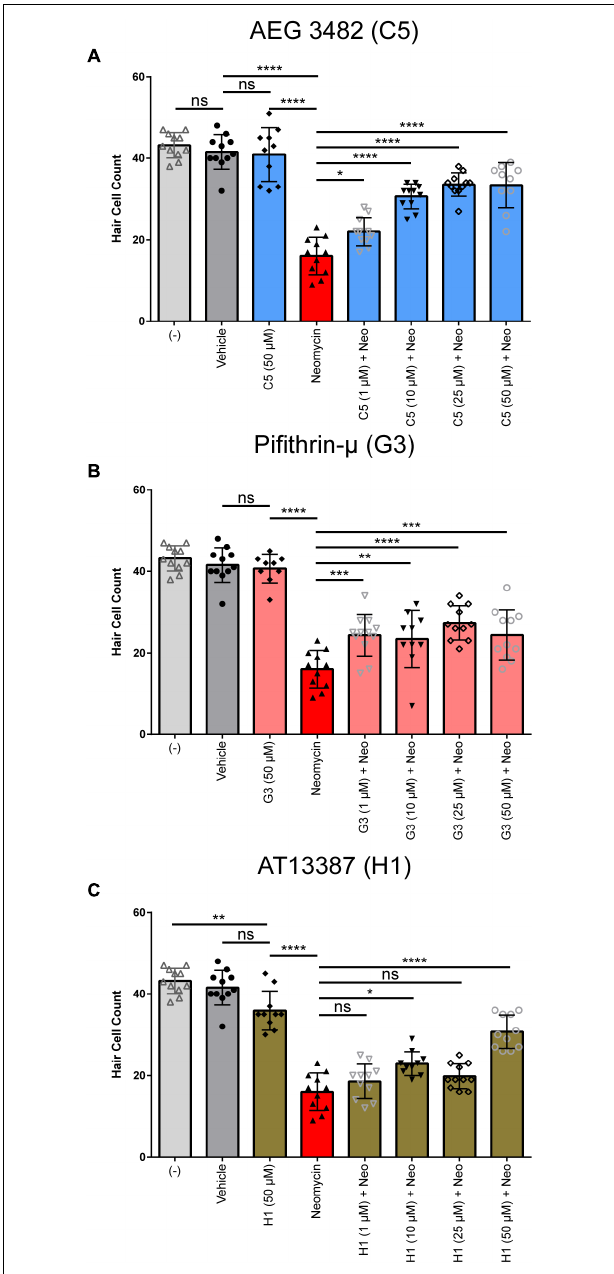
FIGURE 5 | All perturbagen hits show protection against neomycin-induced hair cell death at multiple doses. (A) Dose–response relationship for C5 (AEG 3482, blue). Hair cells were counted from anti-parvalbumin-labeled neuromasts. (B) Dose–response relationship for G3 (Pifithrin- µ , pink), (C) Dose–response relationship for H1 (AT-13387, brown). Negative control, vehicle, and neomycin plus vehicle groups are identical in all three experiments, as all doses for all three drugs were tested in the same experiment ( n = 8–10 per group) but are stratified into separate graphs for clarity of the comparisons being made. Asterisks represent adjusted p-values from Sidak multiple comparisons test following one-way ANOVA with ∗ representing p ≤ 0.05, ∗∗ representing p ≤ 0.01, ∗∗∗ representing p < 0.001, ∗∗∗∗ representing p < 0.0001, and ‘ns’ (not significant) representing p > 0.05. All error bars in (A–C) represent ± SD